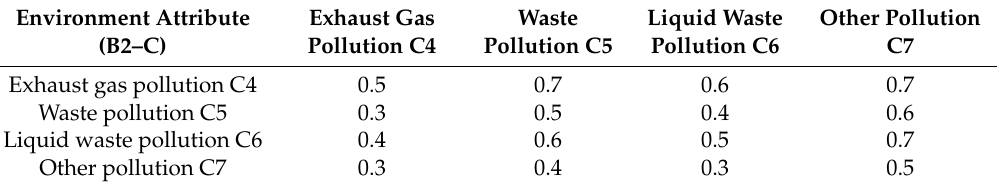
Table 6. Layer judgment matrix (B2–C).